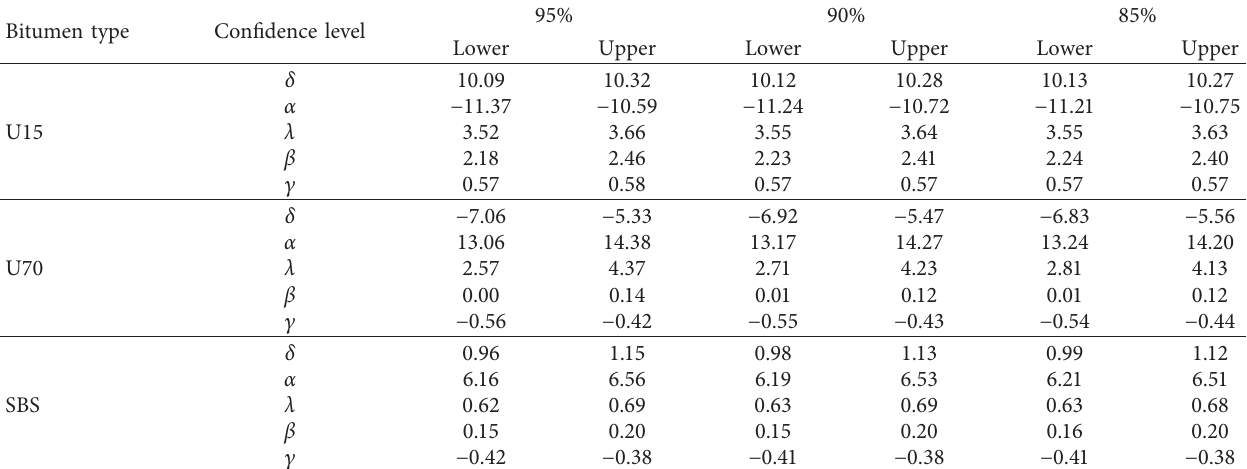
Table 2: The confidence interval constructed for different bitumen using the GS